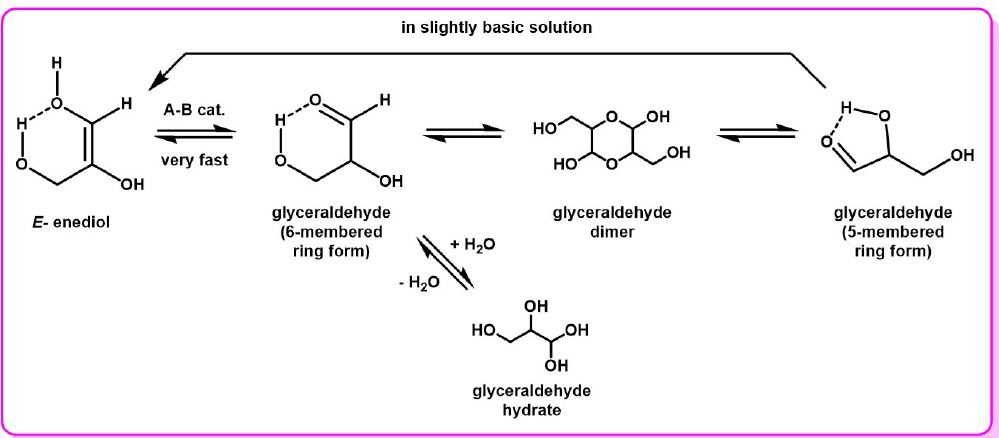
Figure 9. Di ff erent forms of glyceraldehyde in aqueous solution. Figure 9. Different forms of glyceraldehyde in aqueous